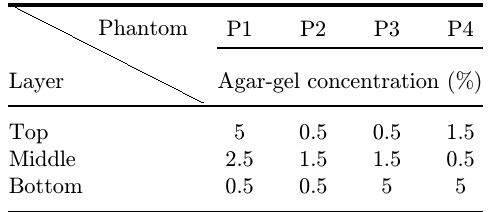
Table 1. Compositions of agar-gel tissue phan- toms used